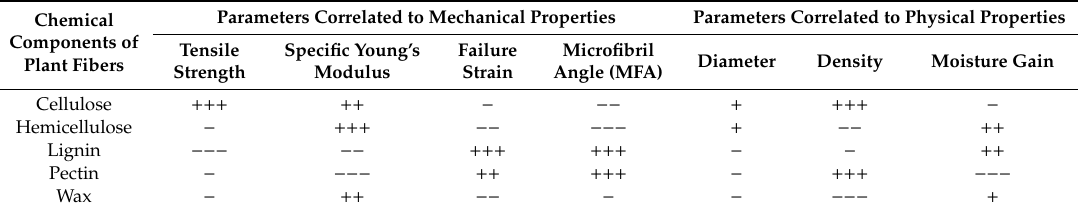
Table 1. Qualitative analysis of the influence of chemical composition on the mechanical and physical properties of plant fibers. Based on reference